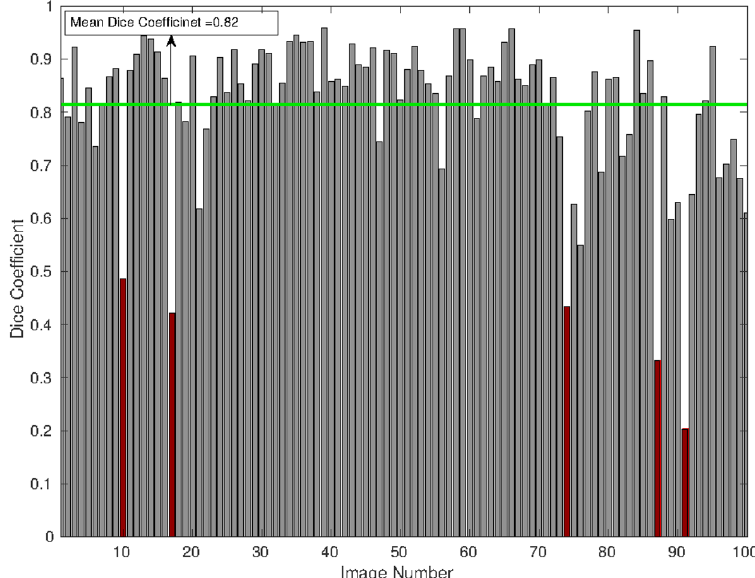
Figure 5. The accuracy of root image detection using saRIA vs. manual segmentation (ground-truth data) in terms of the Dice similarity coefficient (DSC). The green line points to the mean DSC value over 100 tested soil-root images. The red color bars indicate few cases of poor saRIA performance with a low DSC value that corresponds to roots in the early stage of plant development.